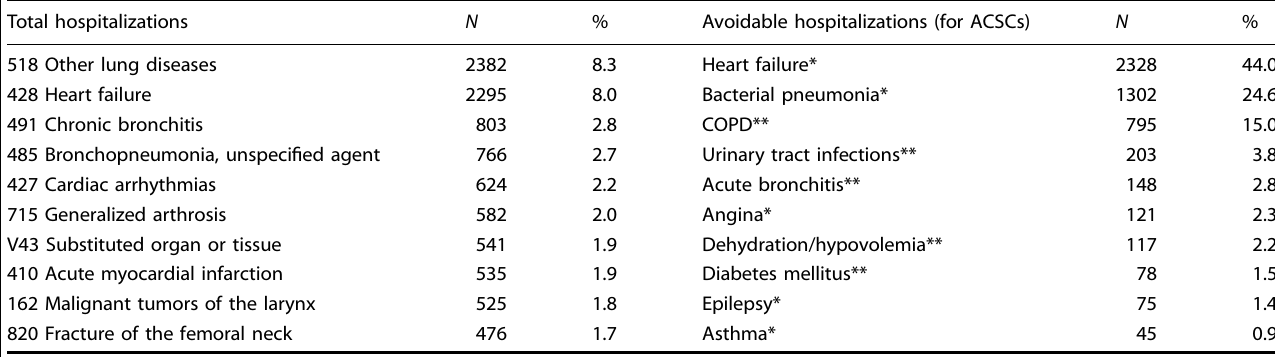
Table 2. Most frequent reasons for hospitalization (total and avoidable) by primary diagnosis in the whole study sample, years 2017 – 2018. Total